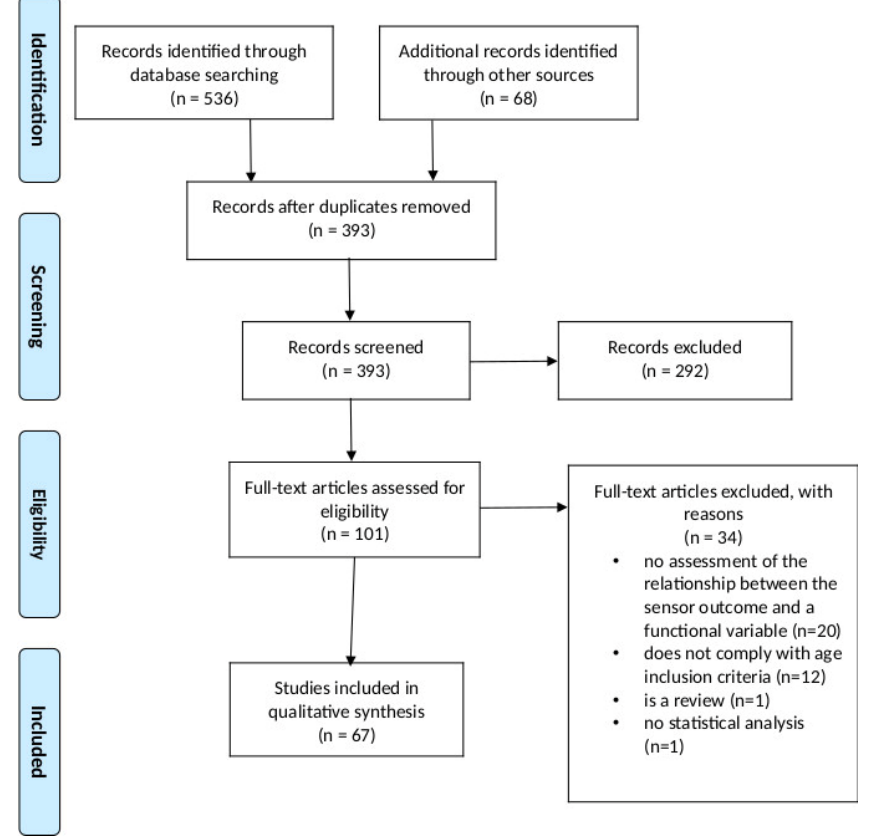
Figure 1. PRISMA flow diagram. Sensors 2021 , 21 , x FOR PEER REVIEW